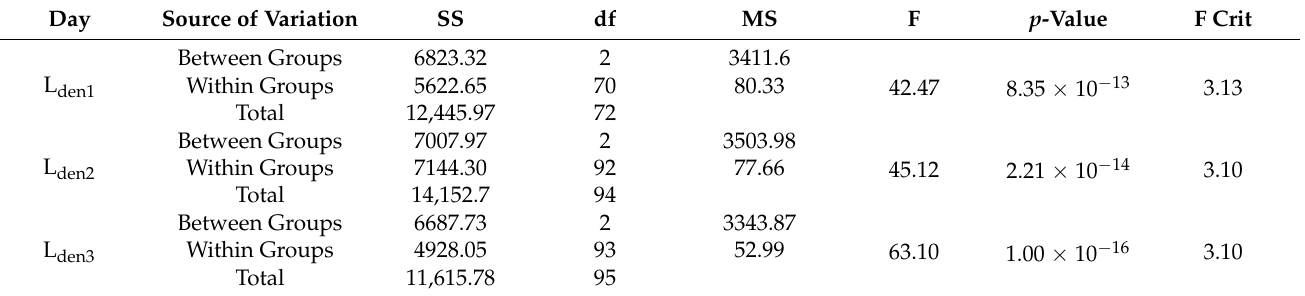
Table 5. ANOVA evaluation of noise comfort parameters in both ICUs for all days considering the day, evening, and night